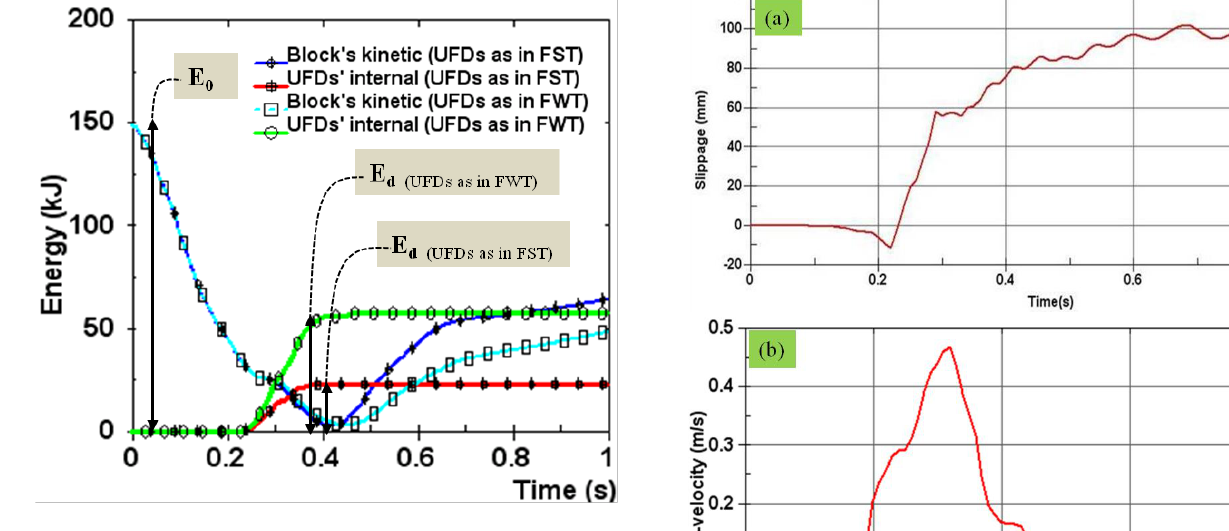
Figure 13. Comparison of numerically simulated energy transfomation time histories and energy dissipation by the UFDs having different constitutive behaviours when integrated into the R-LPR structure. The red (dotted) lines correspond to the UFD behaviour exhibited in the FST (with the computed hardening parameter equal to 0.001) whilst the blue (solid) lines correspond to that in the FWT (with the computed hardening parameter of 0.0001).